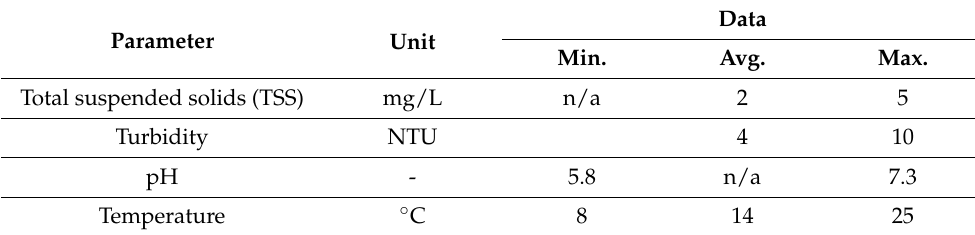
Table 2. Raw water analysis before pilot